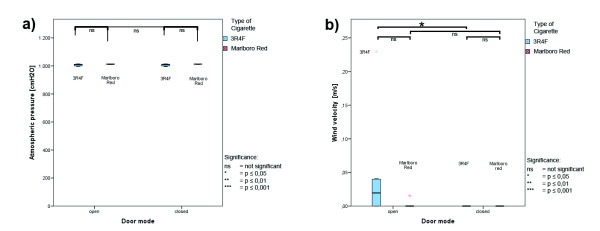
Climate parameters during ETS measurement – air pressure and wind velocity. a) atmospheric pressure; b) wind velocity; red: Marlboro Red; blue: 3R4F reference cigarettes; values are averages for the total time interval.